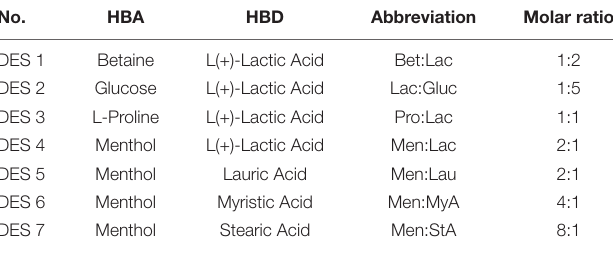
TABLE 1 | An overview of the tested